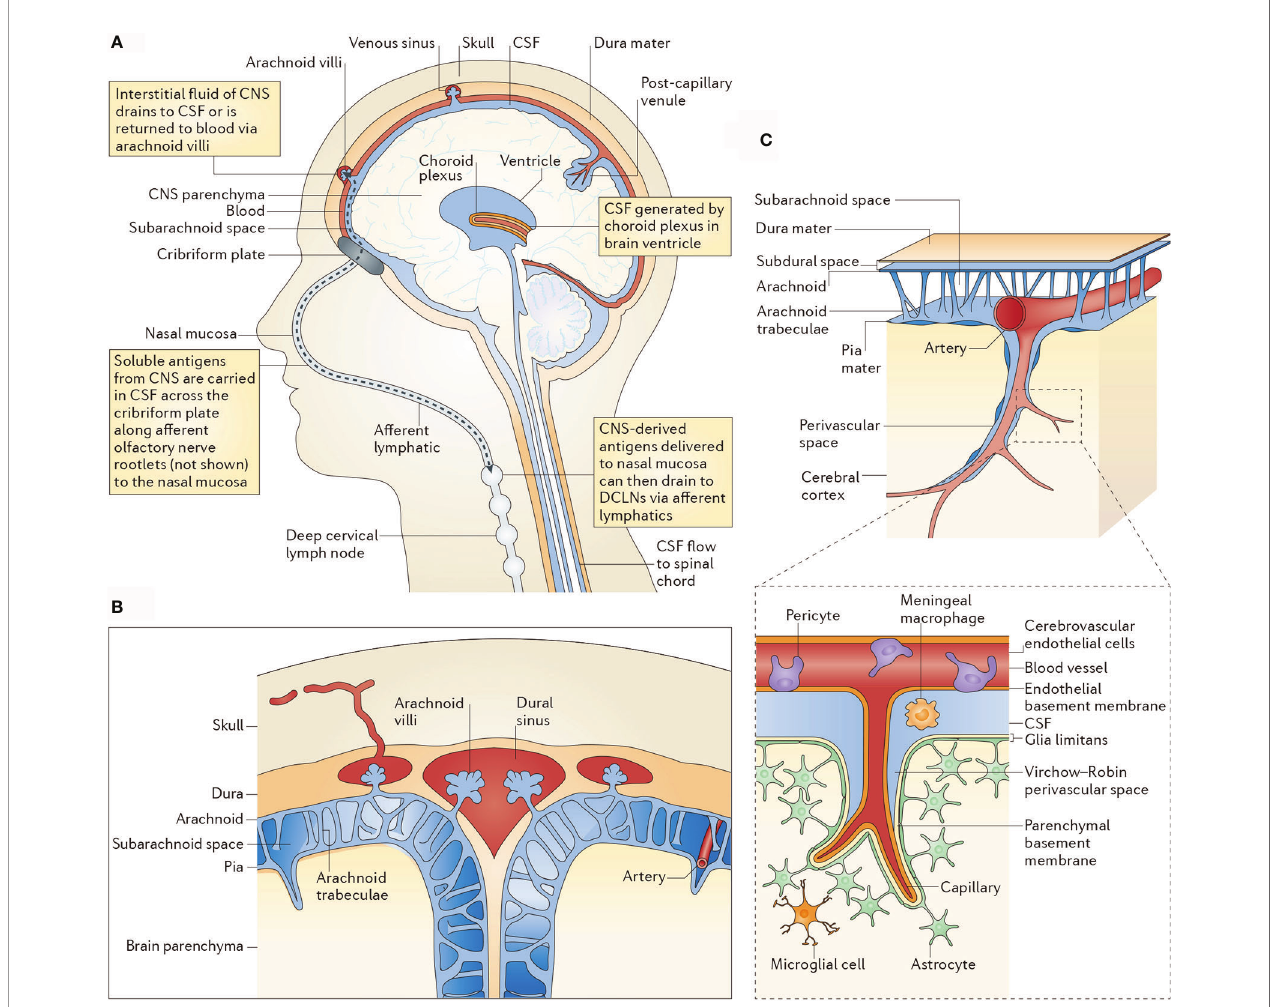
FIGURE 2 | CSF-mediated drainage of interstitial fl uid and CNS antigens to deep cervical lymph nodes. (A) A human head in midline sagittal section, showing revelant anatomical structures [namely the ventricle, choroid plexus, central nervous system (CNS) parenchyma, lymphatics and deep cervical lymph nodes (DCLNs)] in schematic form. (B) Arachnoid granulations in relation to the subarachnoid space and brain parenchyma. (C) Subpial vasculature in relation to subarachnoid space and brain parenchyma, indicating the anatomy discussed in the main text. The inset shows the cellular components of cerebral capillaries, the glia limitans and the basement membranes in relation to the perivascular space. CSF, cerebrospinal fl